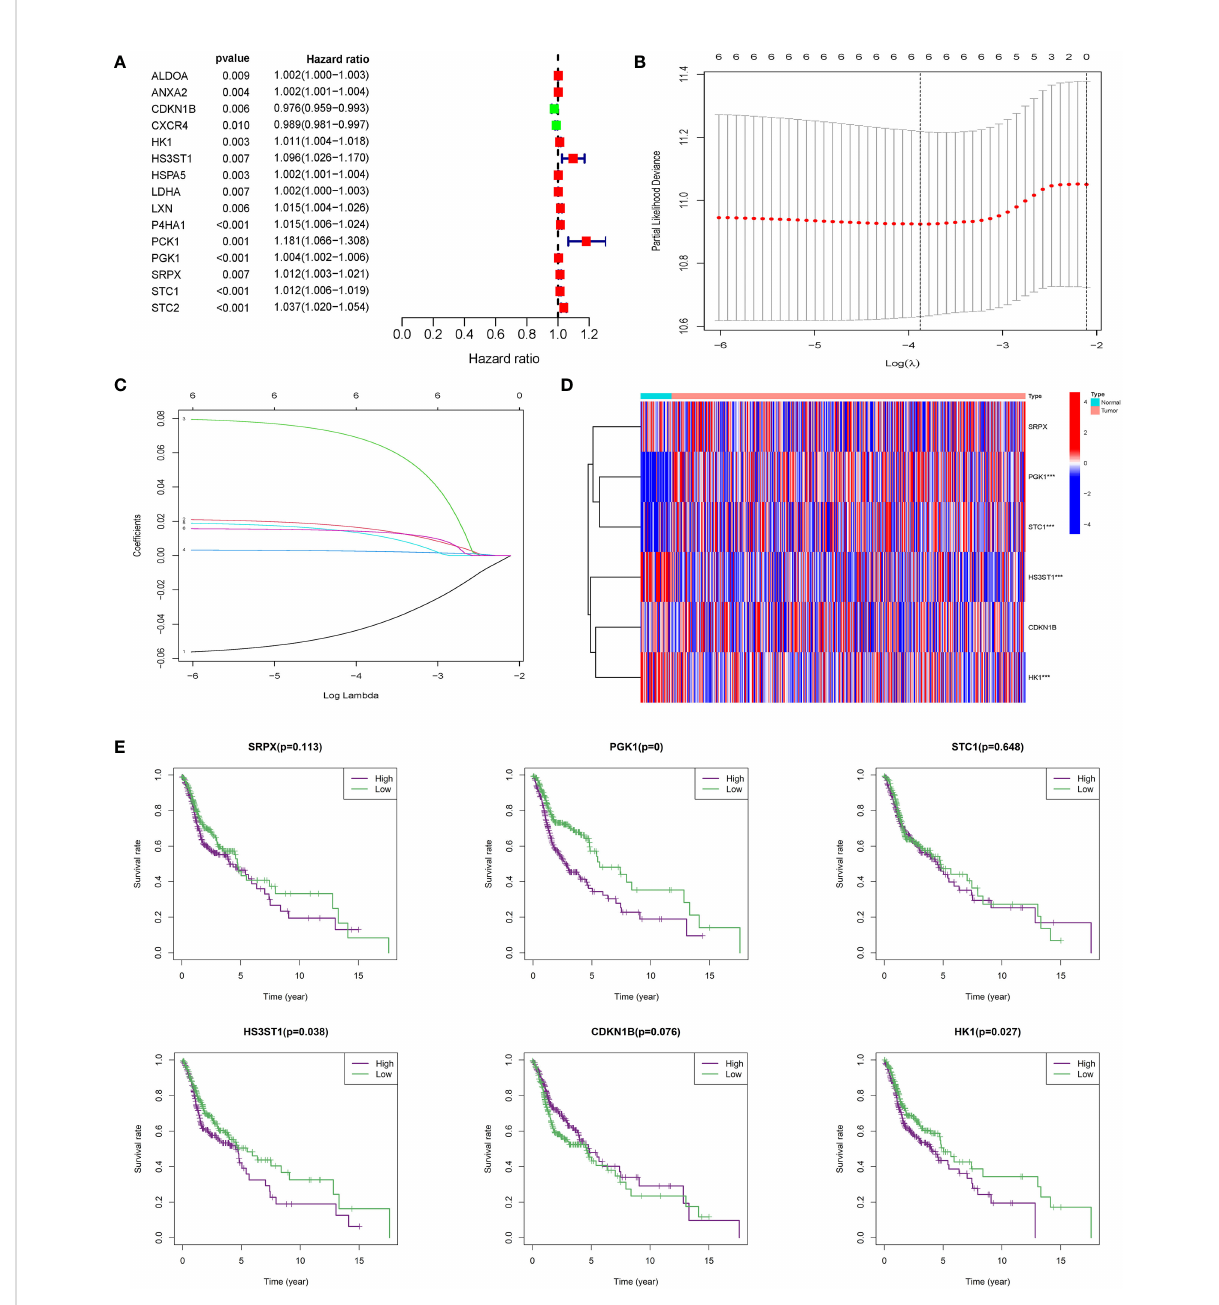
FIGURE 2 Construction of integrated risk score based on HRGs. (A) ALDOA, ANXA2, CDKN1B, CXCR4, HK1, HS3ST1, HSPAS, LDHA, LXN, P4HA1, PCK1, PGK1, SRPX, STC1, and STC2 were signi fi cantly correlated with clinical prognosis in univariate Cox regression model. (B, C) The LASSO Cox analysis identi fi ed six genes associated with prognosis. (D) SRPX, PGK1, STC1, HS3ST1, CDKN1B, and HK1 were differentially expressed between normal tissues and HNSCC tissues. (E) Kaplan – Meier survival curves were plotted for each of the six genes to predict patient